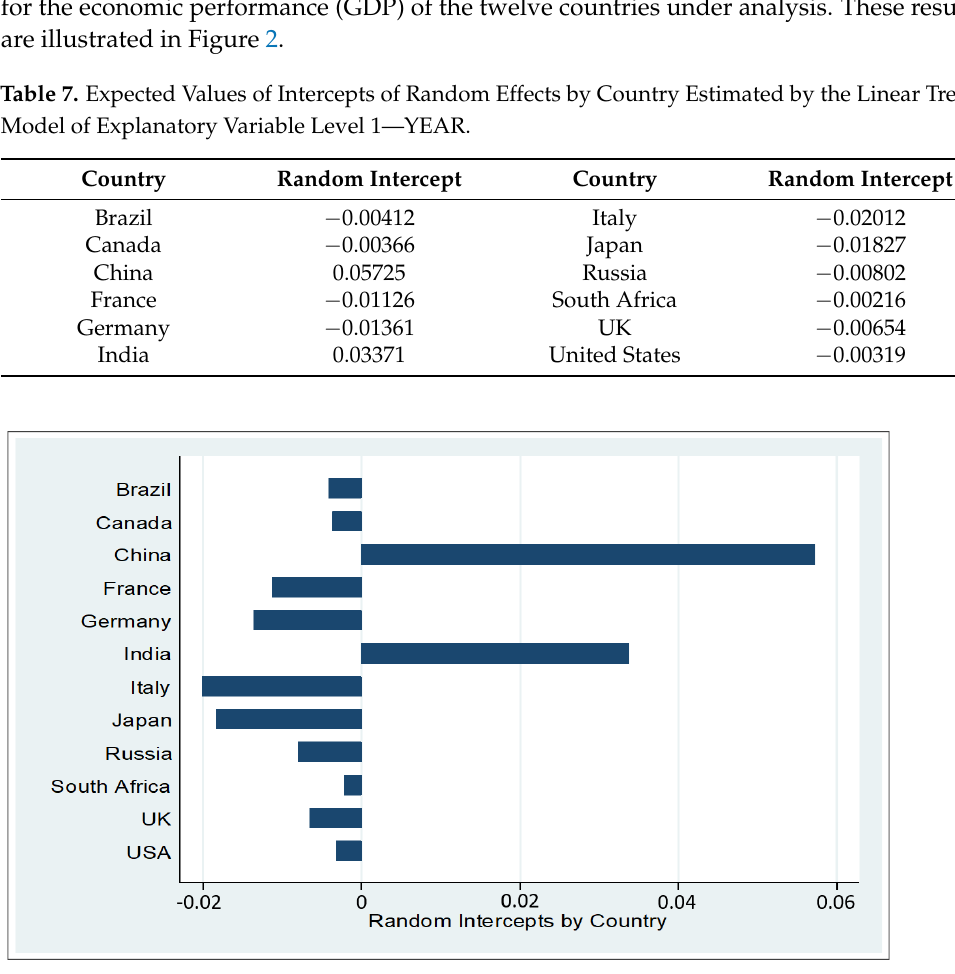
Figure 2. Expected values of intercepts of random effects by country estimated by the linear trend model of explanatory variable level 1 — YEAR.